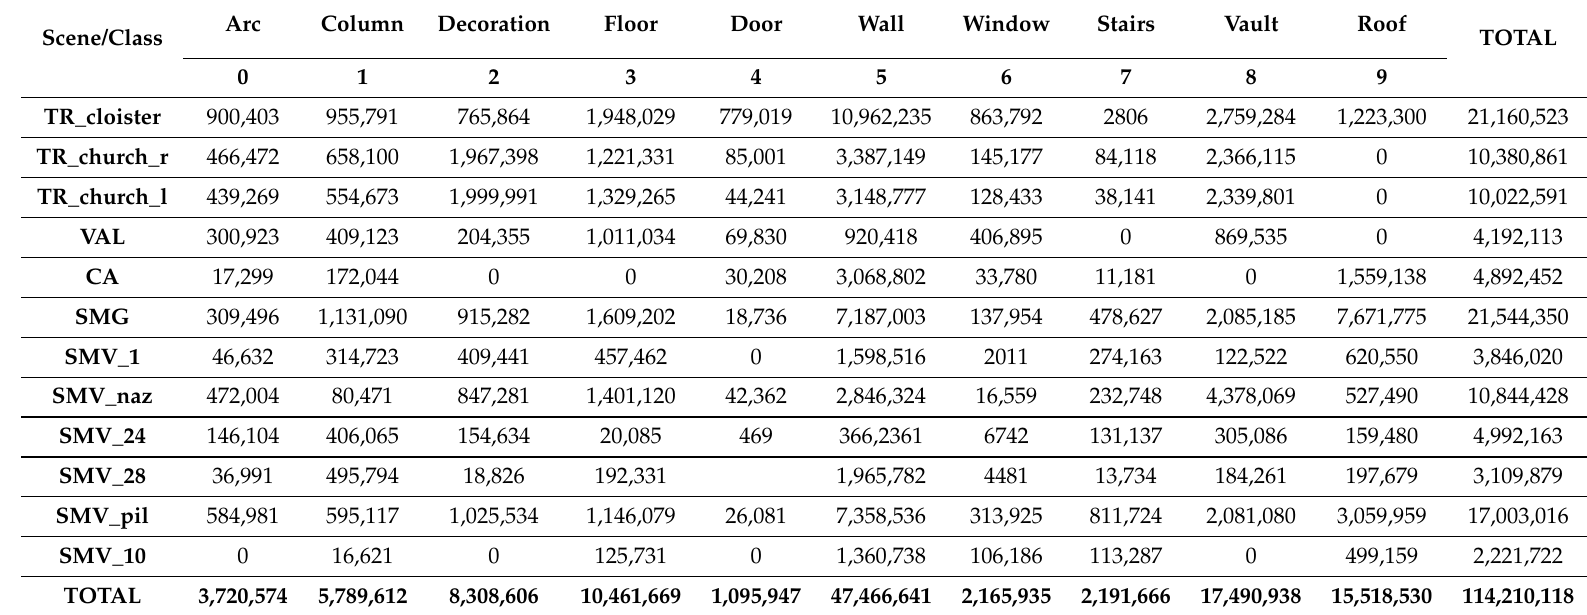
Table 1. Number of points per class and overall for the whole scene. The point cloud of the Trompone church has been split into right (r) and left (l) part according to the tests conducted in Section